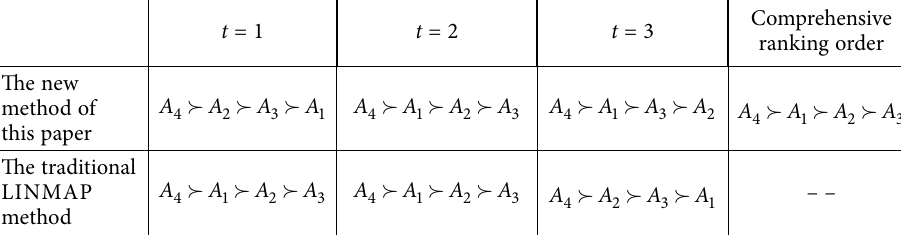
Table 6. Summary of analysis results of PPSQ example